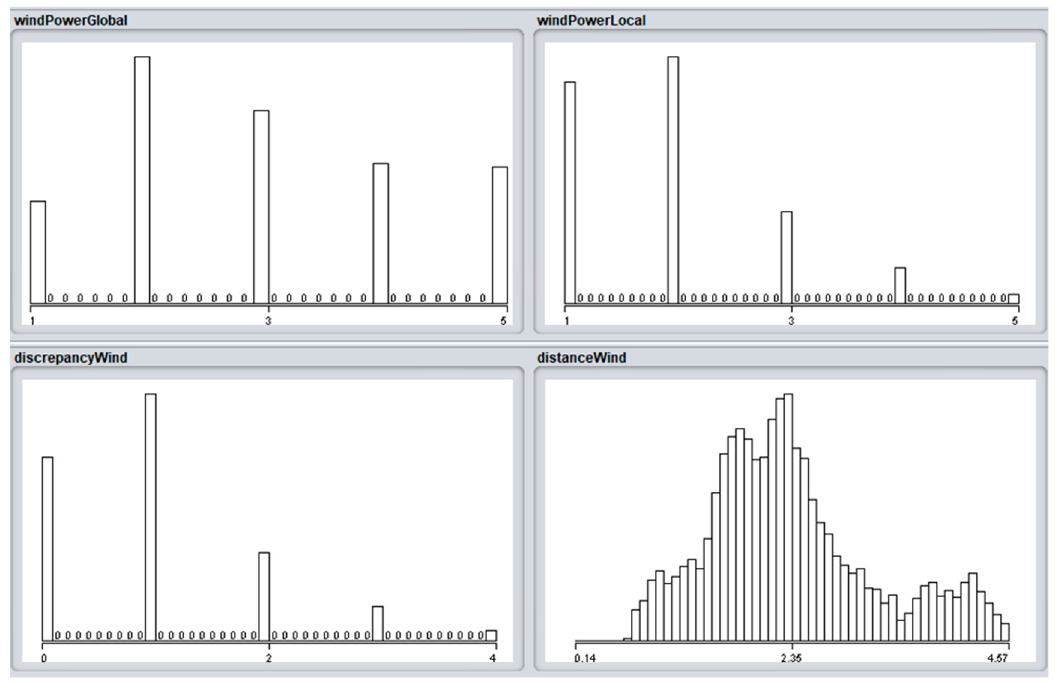
Figure 5. The panels ‘windPowerGlobal’ and ‘windPowerLocal’ show the distribution of global and local voting values for wind power on a qualitative scale from 1 to 5. The panels ‘discrepancyWind’ and ‘distanceWind’ illustrate the distribution of discrepancies between global and local voting values and the distribution of potential distances (km) to the nearest wind turbine.